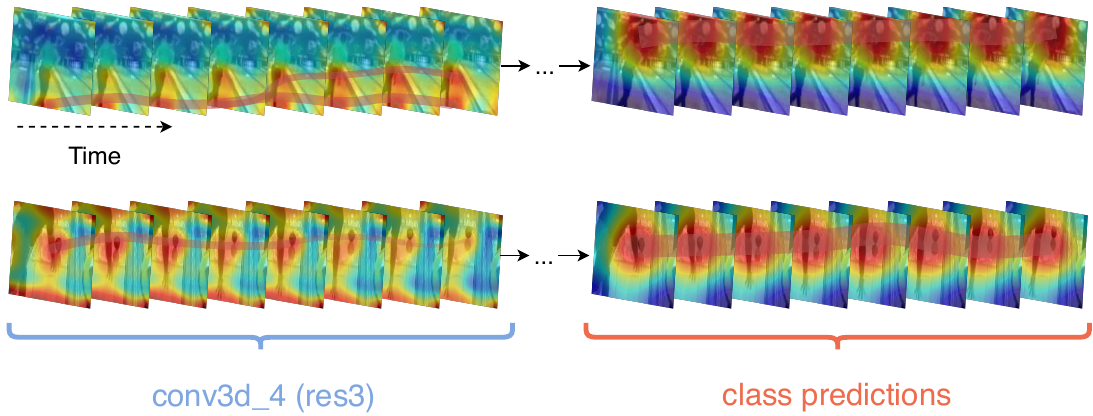
Figure 2. Layerwise class feature correspondence. Each of the Saliency Tubes [29] represents the class activations of a Class Regularized Wide-ResNet50 model in layers res3 and predictions (fc) . Both clips correspond to visualizations for class bowling from Kinetics-400 [30] for two different examples with variations in their spatiotemporal regions.